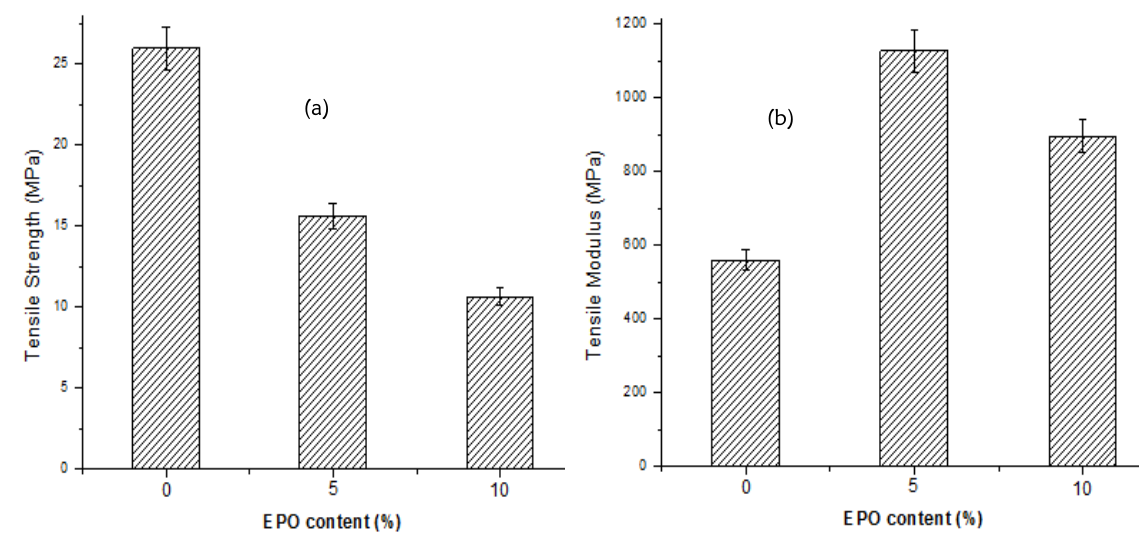
Figure 1: Effect of EPO content of PLA composites on (a) tensile strength and (b) tensile